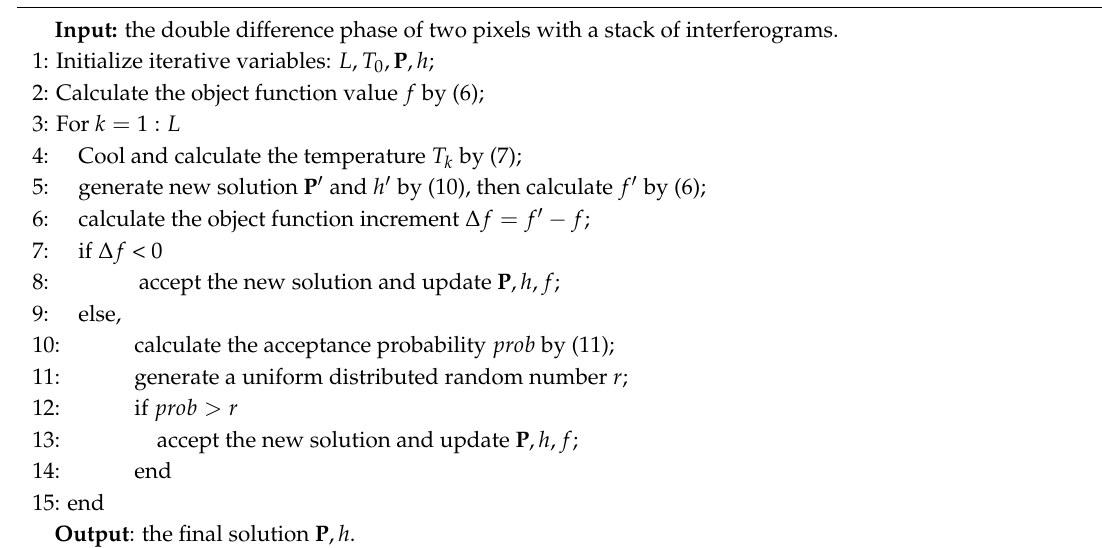
Algorithm 1 SA-based deformation estimation algorithm